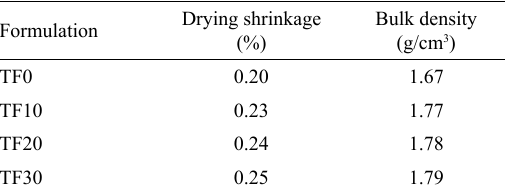
Table 5. Physical properties of the porcelain pieces dried at 110 ºC. Formulation